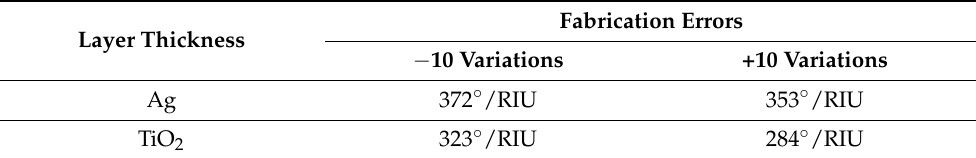
Table 1. The sensitivity of proposed SPR sensor at the refractive index environment of 1.3425 with different fabrication errors.